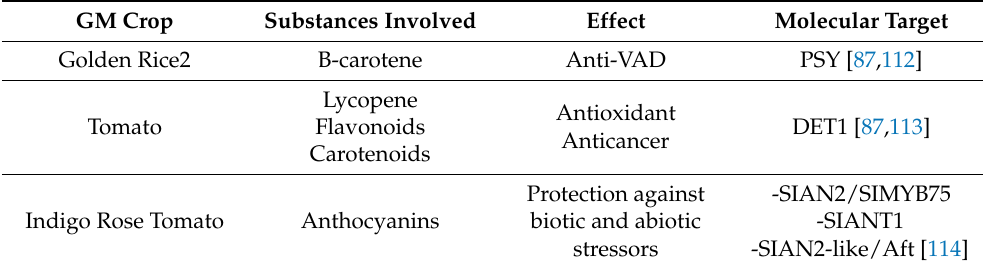
Table 3. Biofortification of GM